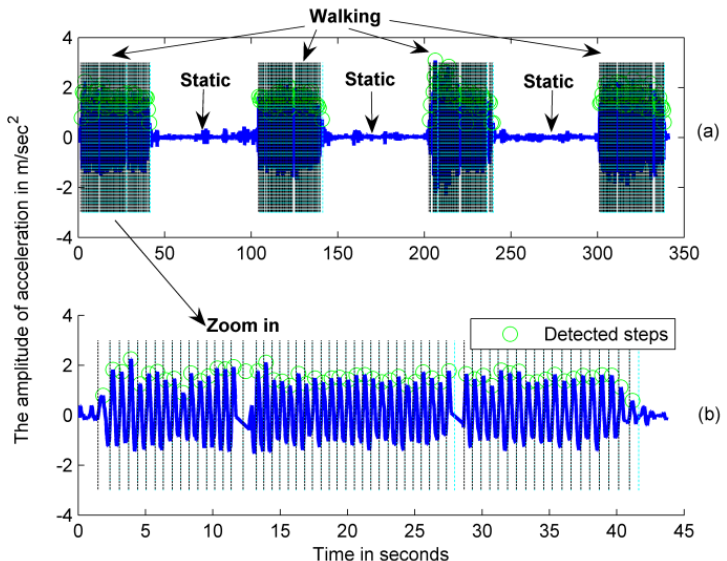
Figure 9. The results of motion state recognition and step detection based on the periodic acceleration pattern of a pedestrian. The blue line is the smoothed pedestrian acceleration, and the green circles indicate the detected steps.